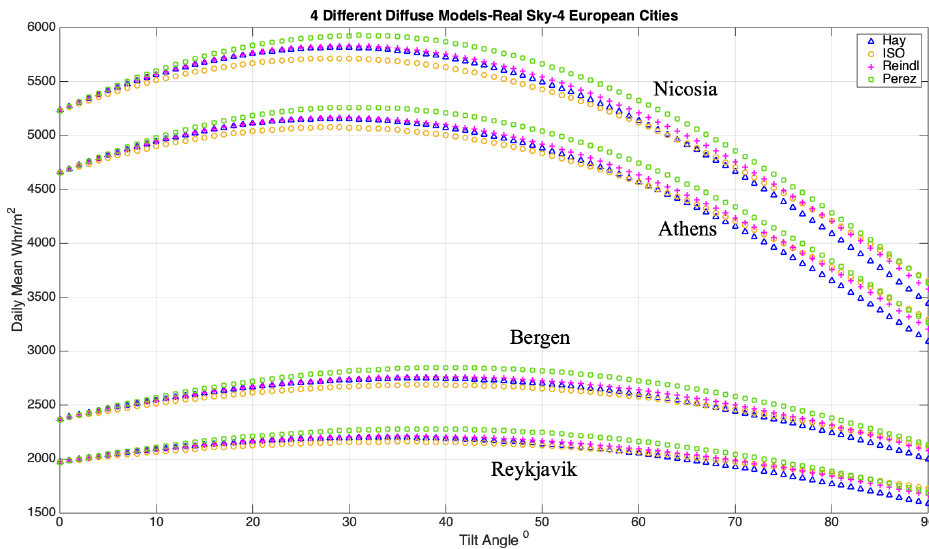
Figure 3. Mean Daily Total Radiation for Athens, Nicosia, Bergen and Reykjavik, for inclinations of 0° to 90° as calculated by different models. Table 1. Mean Optimum Angle for test cities as calculated with each model, the mean and standard deviation σ for each city as calculated from model’s prognosis.